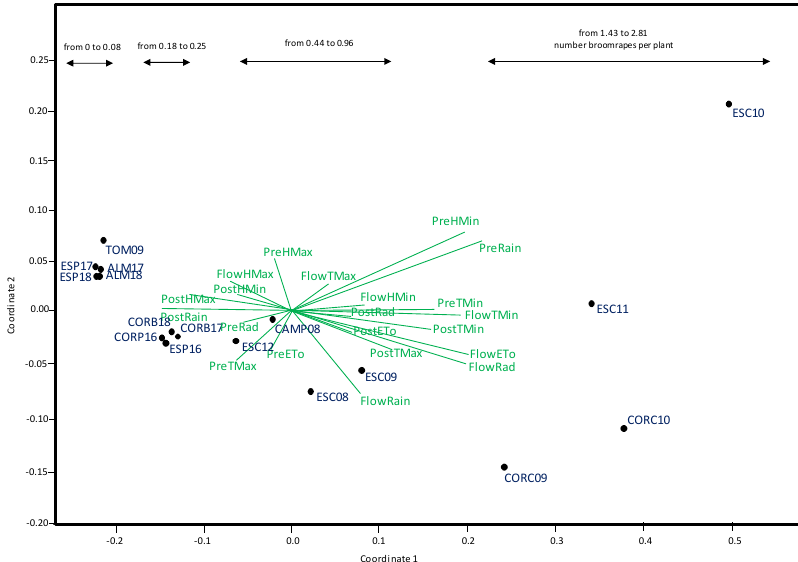
Figure 4. Non-metric multidimensional scaling (NMDS) analysis of the climate variables characterizing the 17 environments, used for phenotyping grain yield.